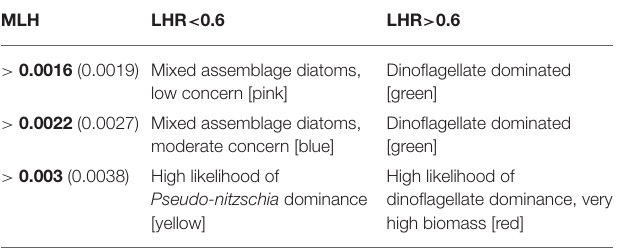
TABLE 2 | The framework for probabilistic phytoplankton community classification (PPCC), based on thresholds of maximum line height (MLH) and line height ratio